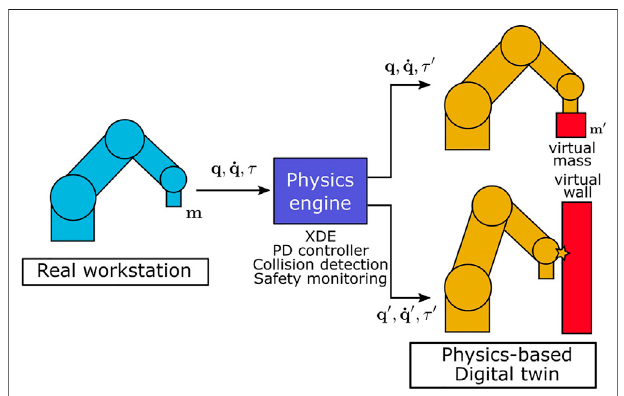
FIGURE 3 | Principleofaphysics-baseddigitaltwin.Redobjectsarepurely virtualanddonotexistintherealworkstation,buttheycanbetakenintoaccountin the physics engine computations. The outputs of the physics engine (joints positions, velocities and torques) may differ from the real